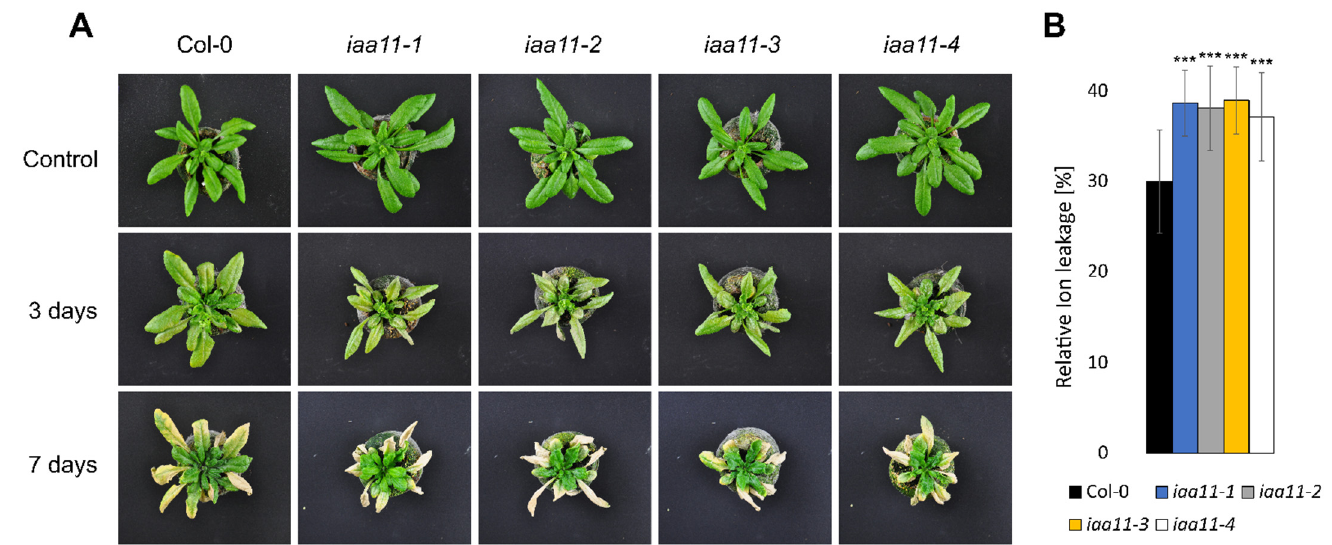
Figure 3. UV-AB susceptibility of Aux/IAA11 mutants . ( A ) Photographs of tested Arabidopsis thaliana plants before, and 3 and 7 days after, the UV stress exposure. ( B ) Relative ion leakage measured 3 days after UV stress exposure. n = 9, Dunnett’s test (*** p < 0.001). Error bars represent the standard deviation.